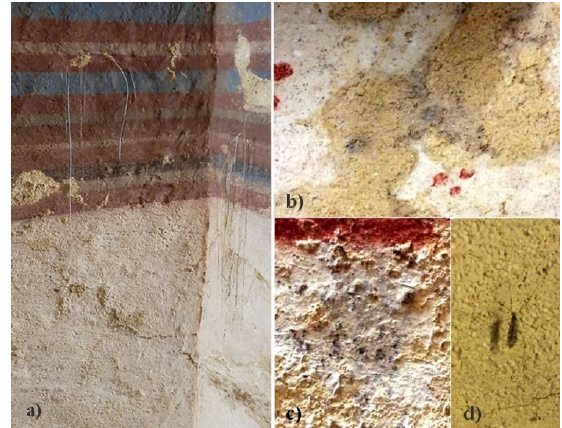
Figure 3. Biodegradation patterns in the Italian tombs from the Monterozzi Necropolis in Tarquinia. ( a ) Roots—Lotus flower Tomb; ( b , c ) fungal dark discoloration—Moretti Tomb; ( d ) Limonia cf. nubeculosa —Blue Demons Tomb.